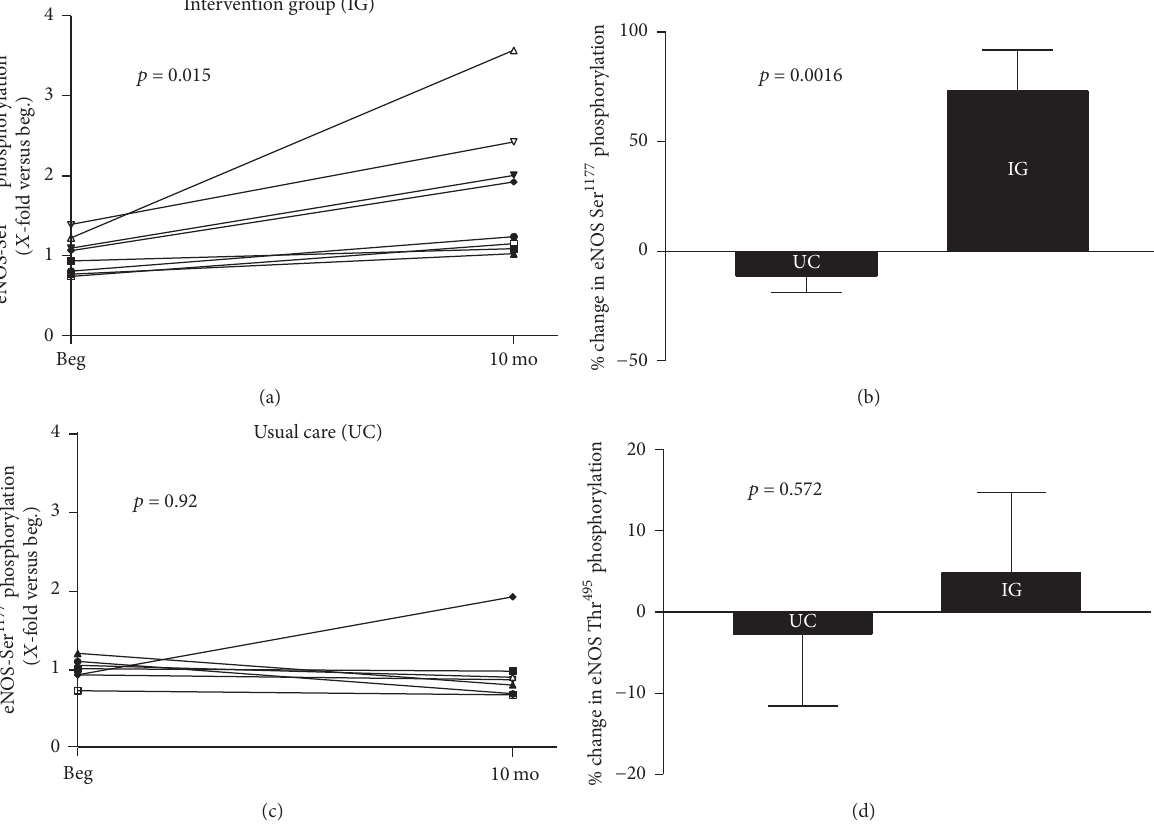
Figure 1: Impact of lifestyle intervention program on HDL-mediated eNOS phosphorylation. Ten months of intervention increases HDL- mediated eNOS-Ser1177 phosphorylation in the intervention group when analyzed over time (a) or compared to usual care group (UC) (b). No change in HDL-mediated eNOS-Ser 1177 phosphorylation occurs in UC (c). Phosphorylation of the eNOS-Thr 495 residue was not affected by the intervention program when compared to UC